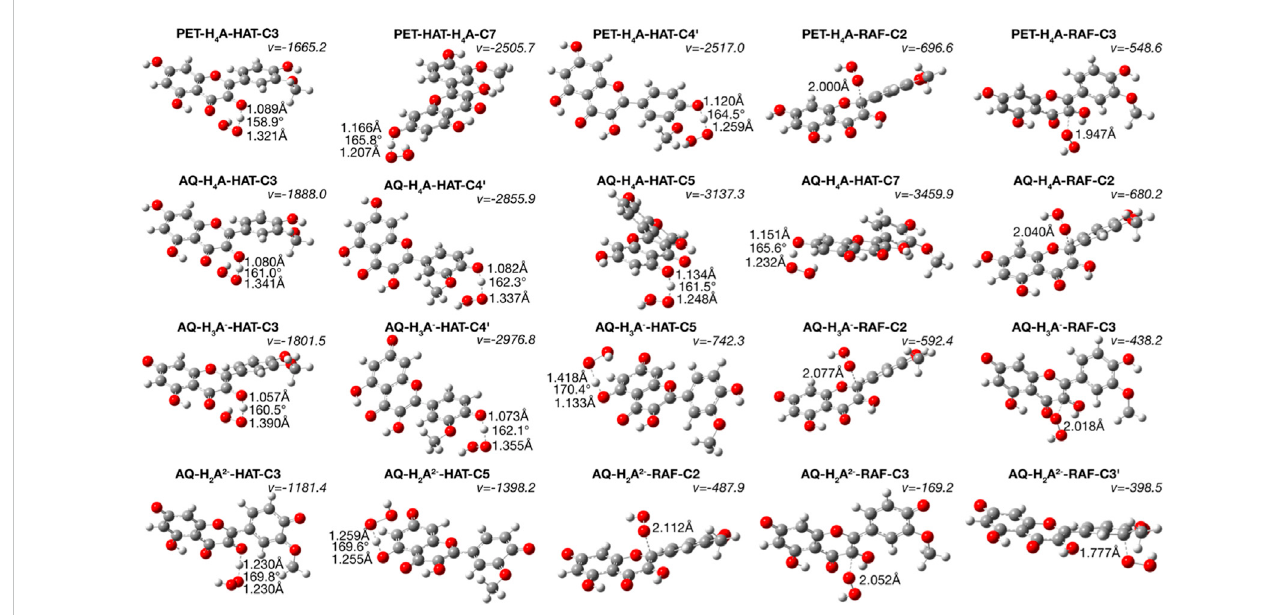
FIGURE 2 TSs structures for HAT and RAF mechanism. Distances are in Å and angles in